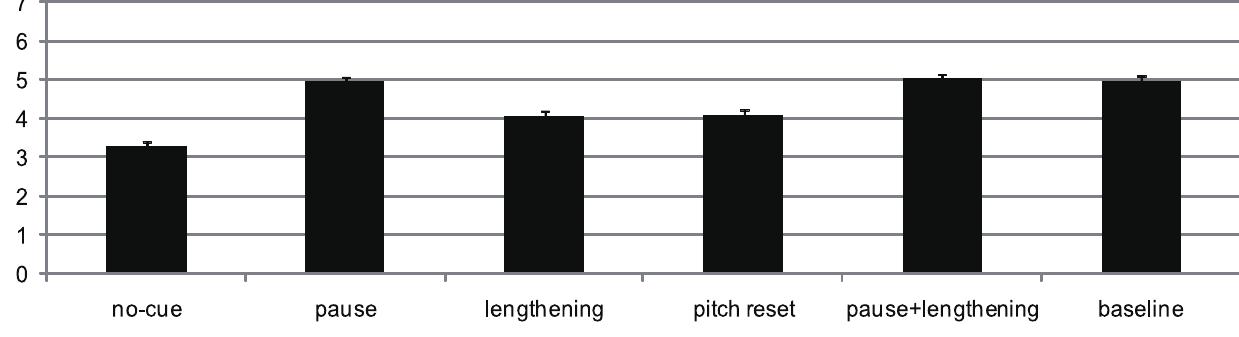
Figure 5. Perceived boundary strength with naturalness rating as covariate.